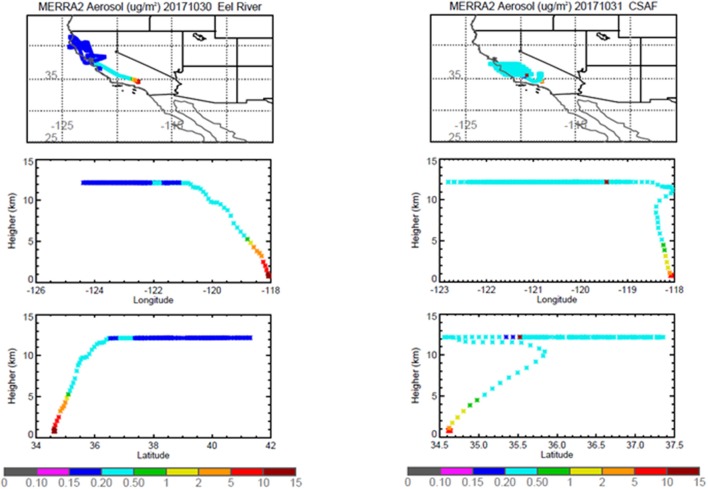
MERRA-2 results depicting bulk aerosol concentration (μg·m−3) for Eel River (Left) and CSAF (Right) flights; top panel shows horizontal cross section and bottom panel shows vertical cross section.